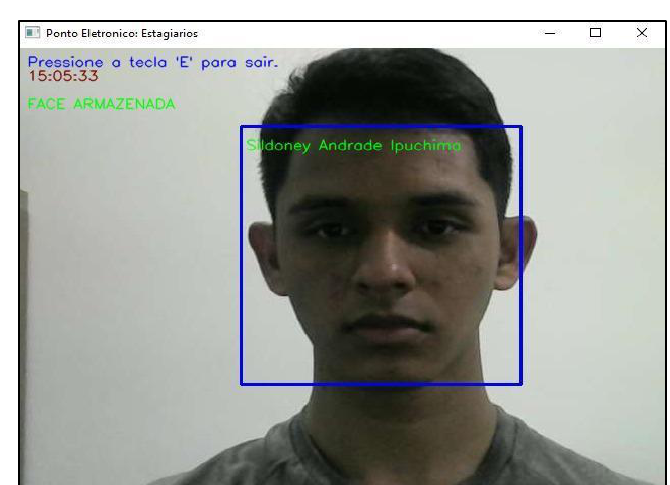
Figure 33: User 2 with user name 1.